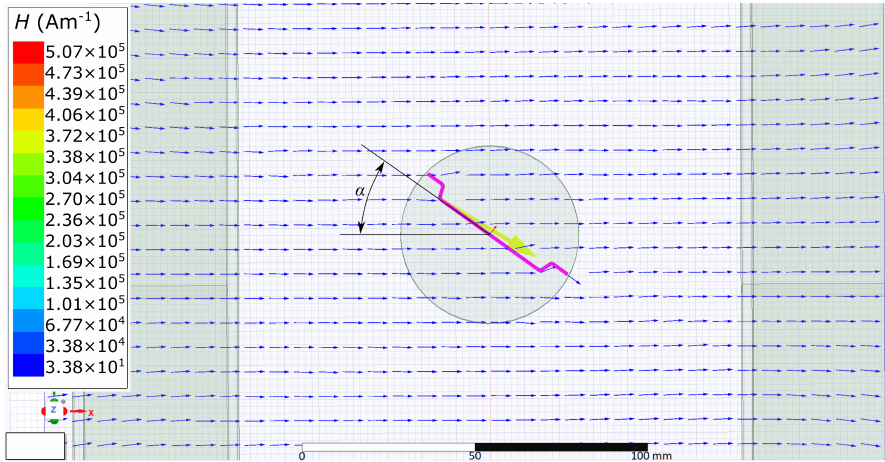
Figure 3. Magnetic field distribution around the fibre and fibre angle